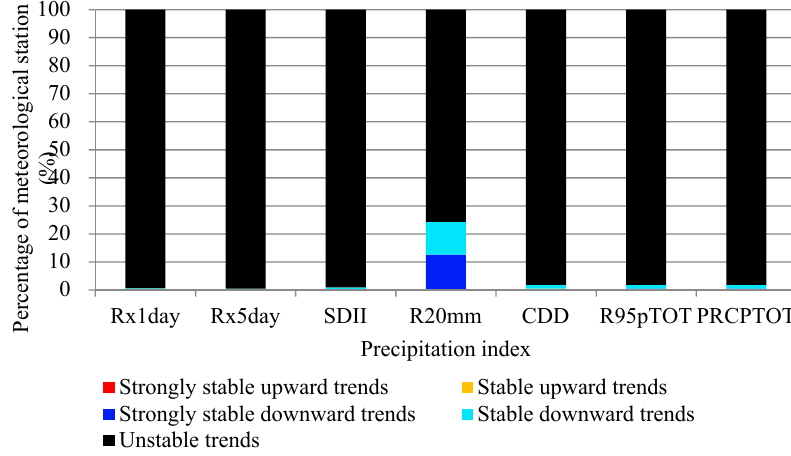
Figure 9. Percentage of stations with stable trends in extreme precipitation indices during the growth period of October 1961 to May 2016.